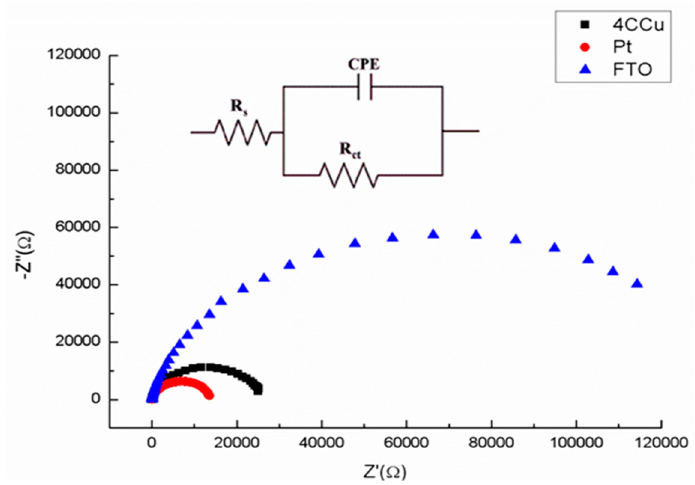
Figure 5. Nyquist plots obtained from EIS experiments of sandwiched cells CE/E/WE in dark con- ditions. FTO/TiO 2 was used as CE, and as WE ( ▢ ) Cu 2 S/FTO modified electrode (n layers= 4), (●) Pt/FTO modified electrode and ( △ ) FTO glass.